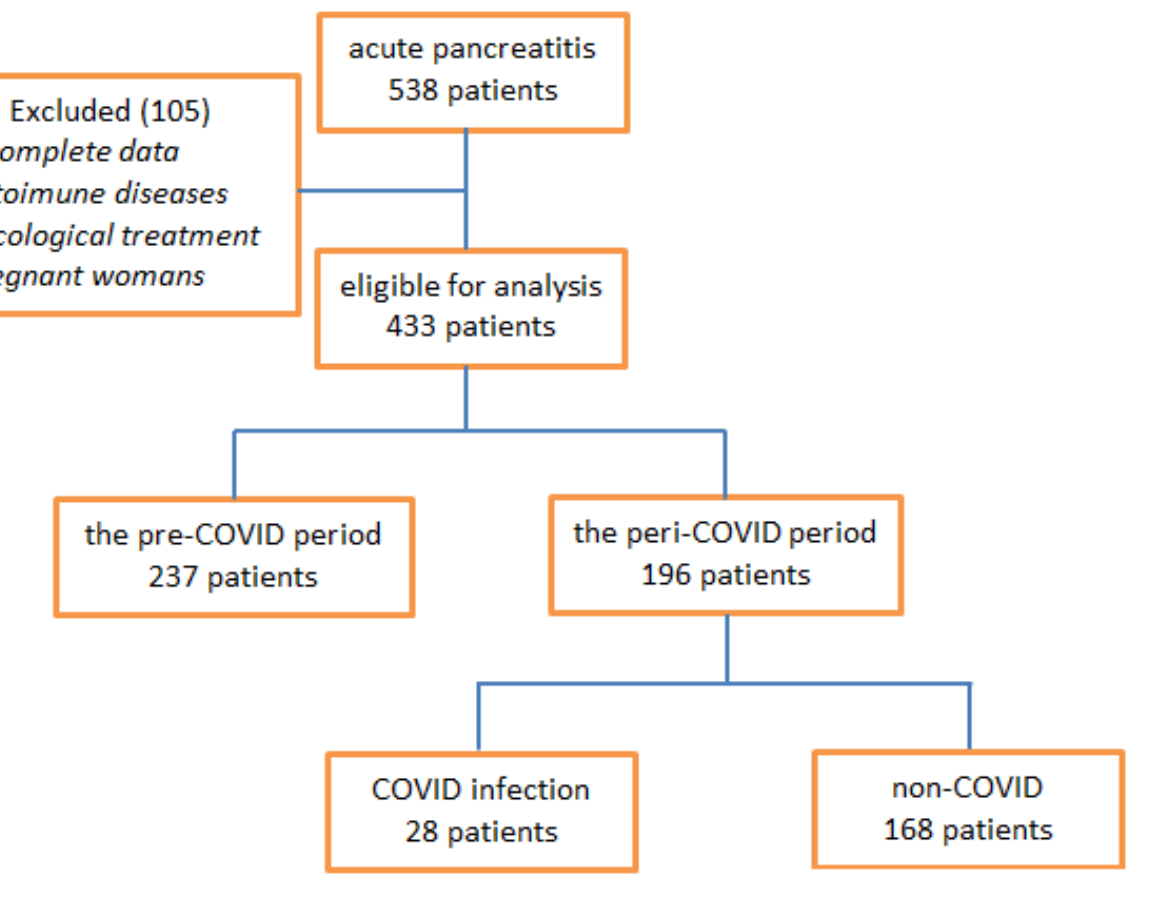
Figure 1. Flow chart of patient inclusion.